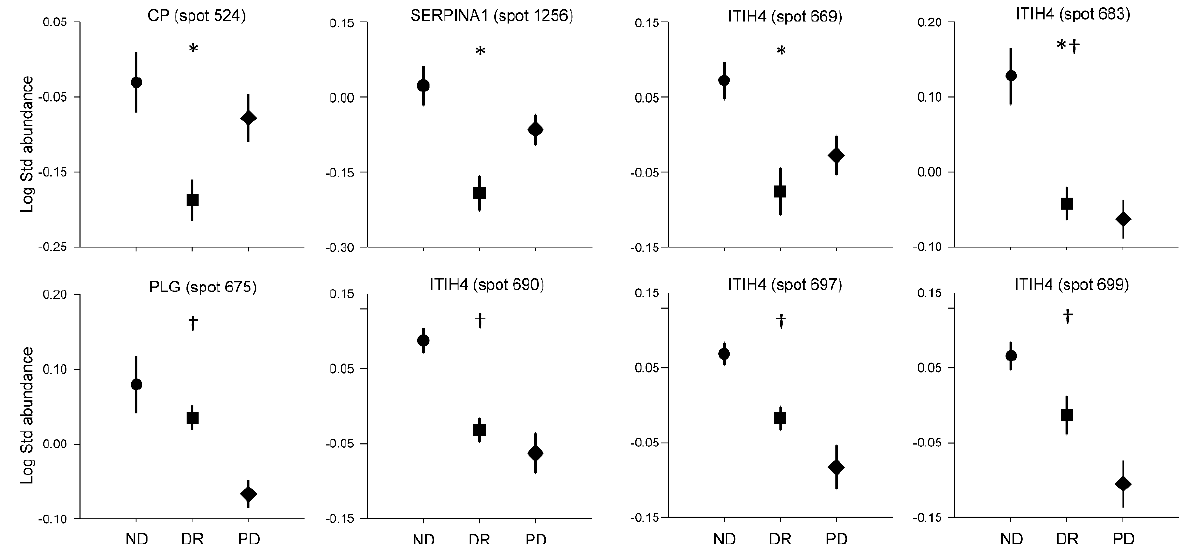
Figure 3. Differences between groups considering baseline and post-surgical values as a whole. ND, non-diabetic patients; DR, diabetes remission; PD, persistent diabetes. Data are means ± SEM. * p < 0.05, differences between ND and DR; † p < 0.05, differences between ND and PD.